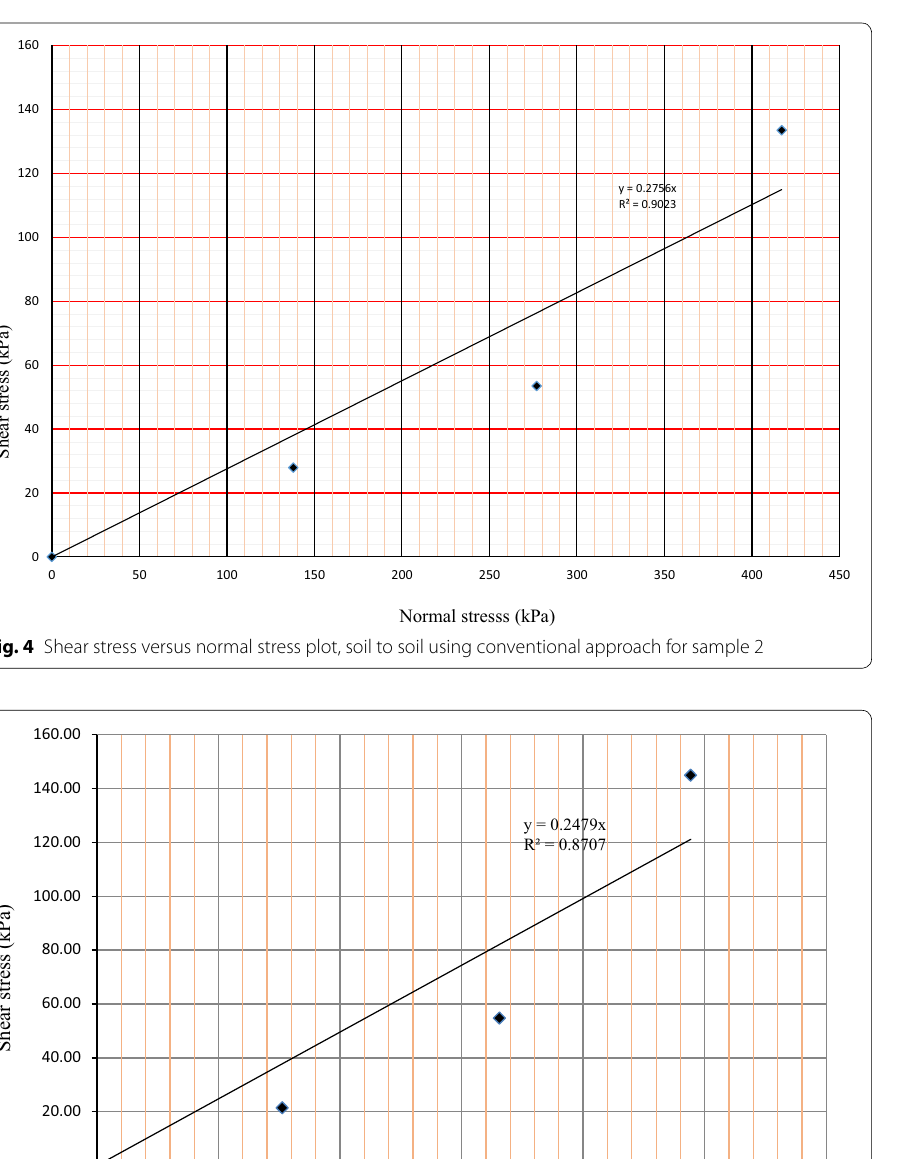
Reference the above, sample set 1 is rougher than sample set 2. Furthermore, the relative roughness is also indicated by ratio of shear force to the normal force ( τ/ friction ratio. This ratio obtained for each externally applied normal load is a measure of the coefficient of static friction (degree of roughness) between the soil and concrete. For the peak shear stress they are 1.40, 0.80, and 0.72 for sample set 1 and, 1.31, 0.73, 0.79 for sample set 2 for the 138, 277, and 477 kPa normal loads respectively. Average values for each of the sample set are 0.97, and 0.94 respectively, indicating that sample set 1 are rougher than sample set 2.